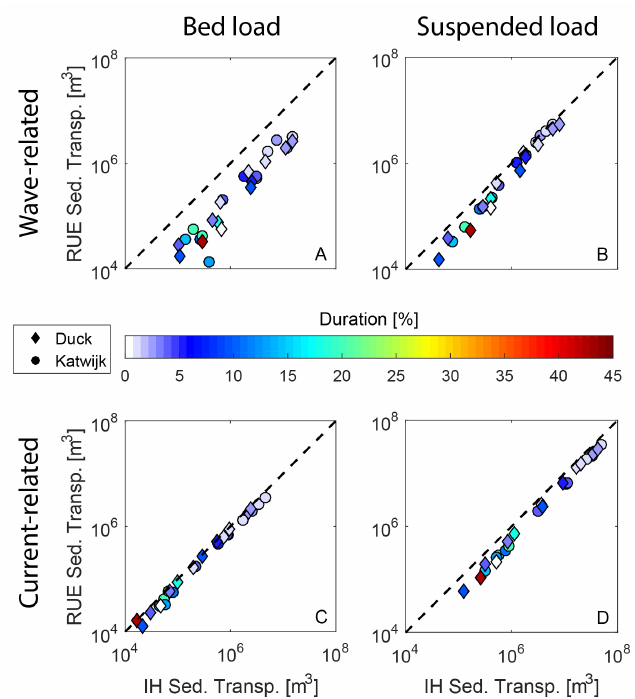
Figure 5. Sediment transport computed with default settings for individual wave conditions integrated over the cross-shore profile and tidal cycle for IH and RUE with colors representing the duration of each wave condition in the reduced wave climate. (A ) wave-related bed load; ( B ) wave-related suspended load; ( C ) current-related bed load; ( D ) current-related suspended load. The dashed line represents a 1:1